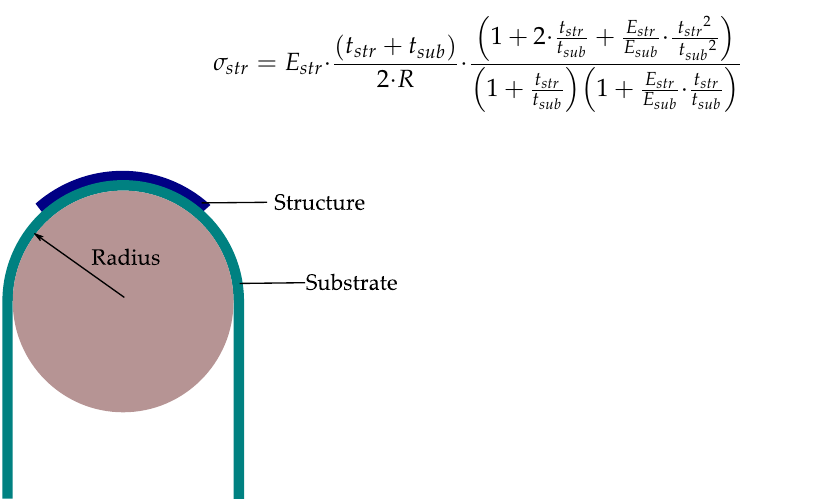
Figure 9. Principle sketch shows a system bent over a defined bending radius. With Equation (10), the bending stress σ str at the top of the structure can be calculated.